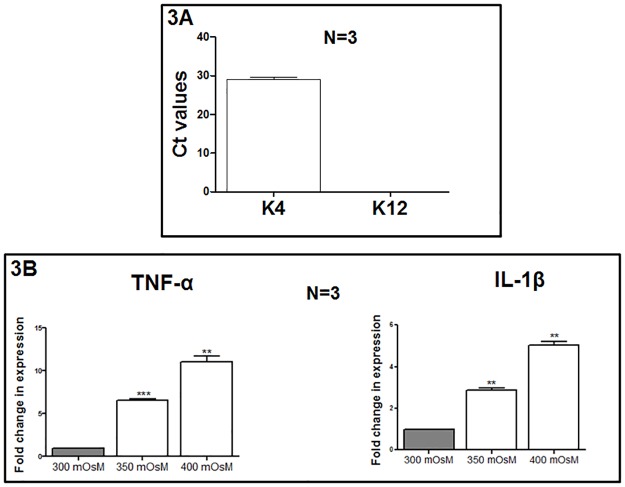
Characterization and hyperosmotic treatment of the mouse conjunctival epithelium primary cells.The confirmation of the origin of primary epithelial cells was done by assessing the levels of cytokeratin 4(K4) and cytokeratin 12(K12) by RT-qPCR (Fig 3A). Under hyperosmotic conditions (350 mOsm and 400 mOsm) for 24h, significant increase in the mRNA expression of proinflammatory cytokine markers, TNF-α and IL-1β, was noted (Fig 3B).